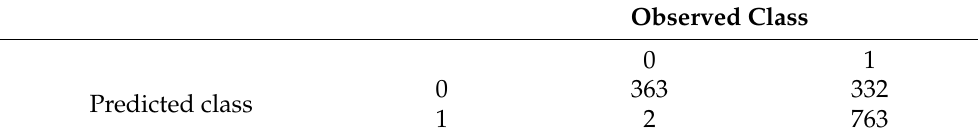
Table 5. Confusion matrix for the RF model on the test set in the two-class classification